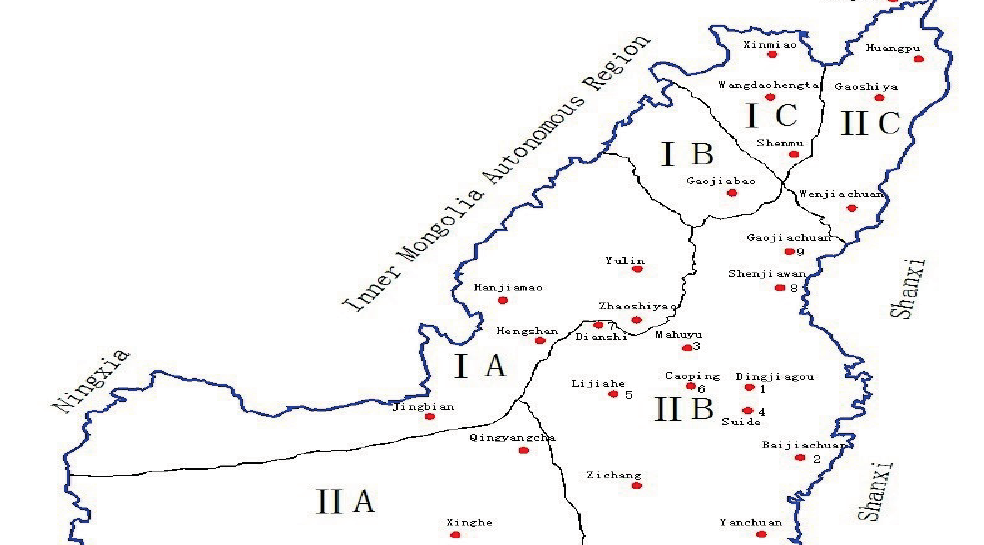
Fig. 1 Schematic map of Yulin city; I: aeolian landform, II: loess hill and gully area. Points indicate hydrometric stations in the